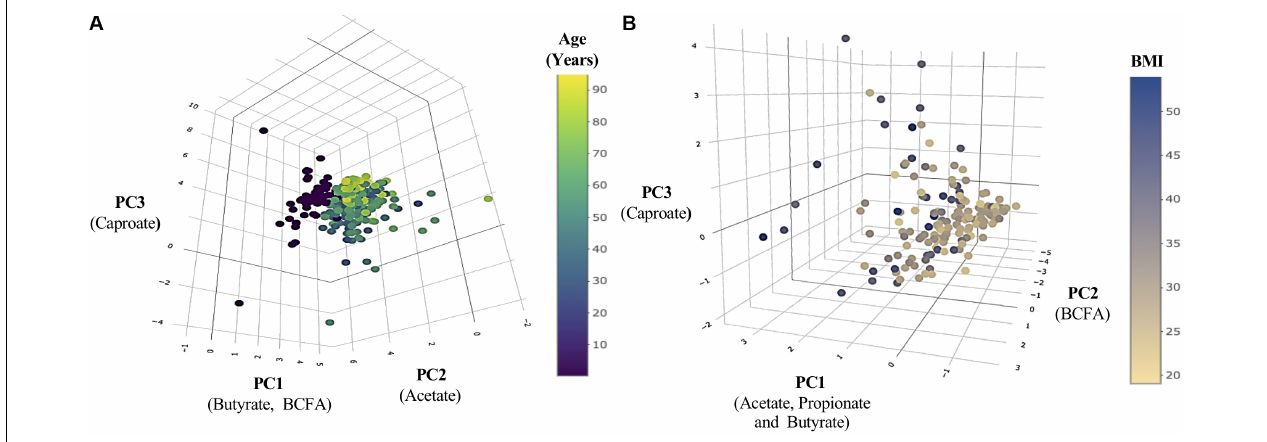
FIGURE 2 | Population distribution regarding changes in SCFA production throughout life and BMI increases. (A) Principal component analysis (PCA) of SCFA production throughout life. (B) PCA of SCFA production according with the increase of BMI. The main components of each axis are indicated below them in parentheses.